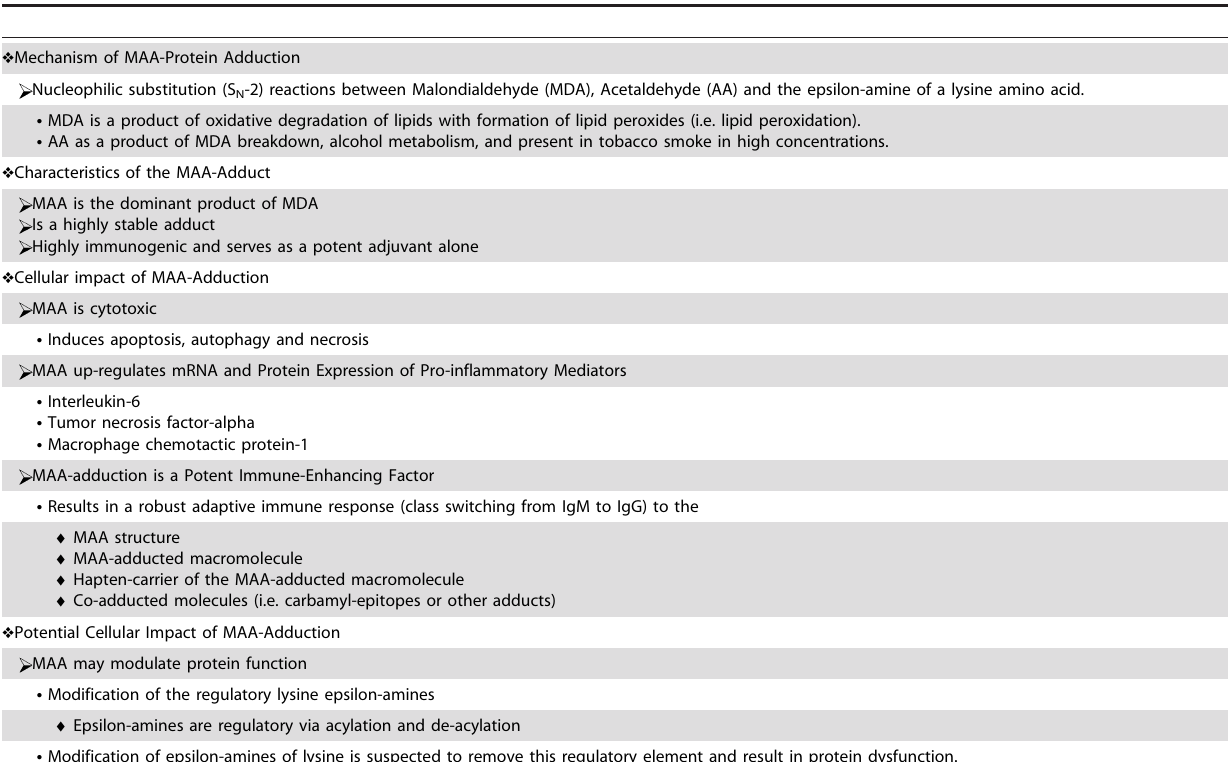
Table 2. MAA-Adduction and its